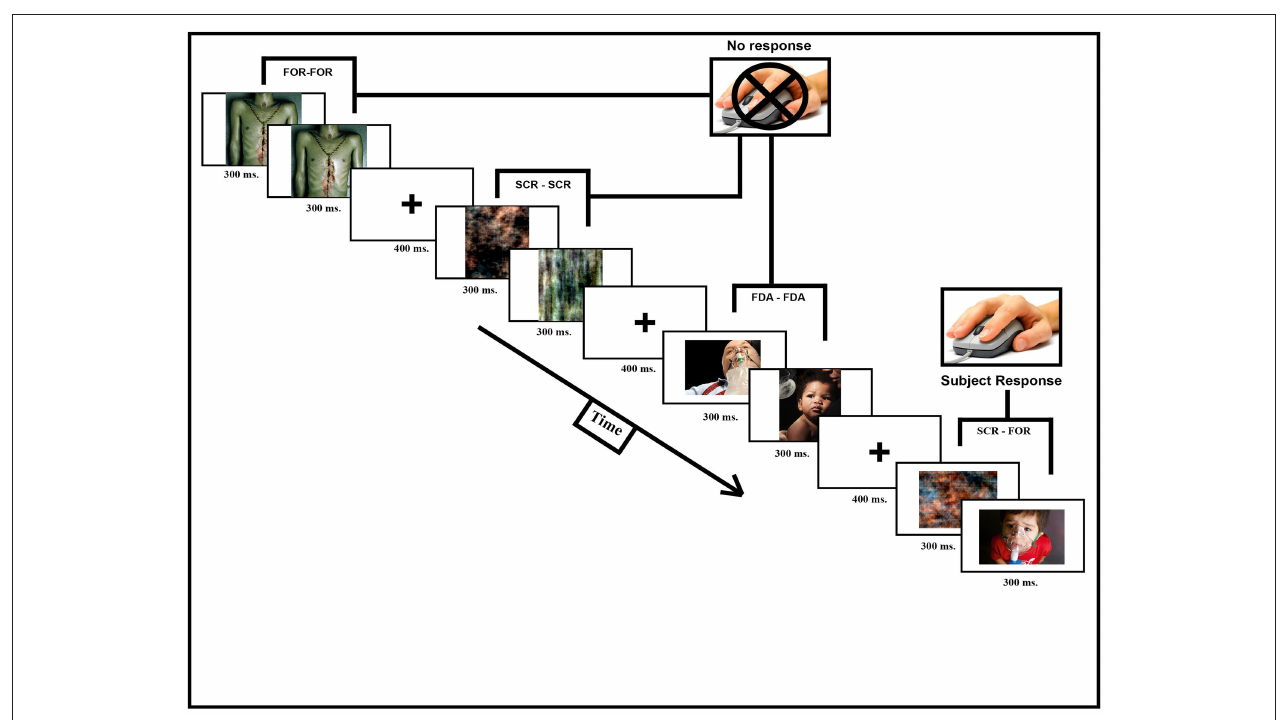
FIGURE 2 | Participants were scanned while observing image pairs (600ms, 300ms per picture) separated by a short pause (400ms). Image pairs could fall into one of seven different categories: HWL ForCon (identical foreign HWLs), HWL DomCon (identical domestic HWLs), HWL ForIncon (different foreign HWLs), HWL DomIncon (different domestic HWLs), SCR Con (identical phase-scrambled images), SCR Incon (different phase-scrambled images), or MisMatch (one phase-scrambled image and one HWL). The participant’s task was to press a button whenever they observed a rare (11%) MisMatch